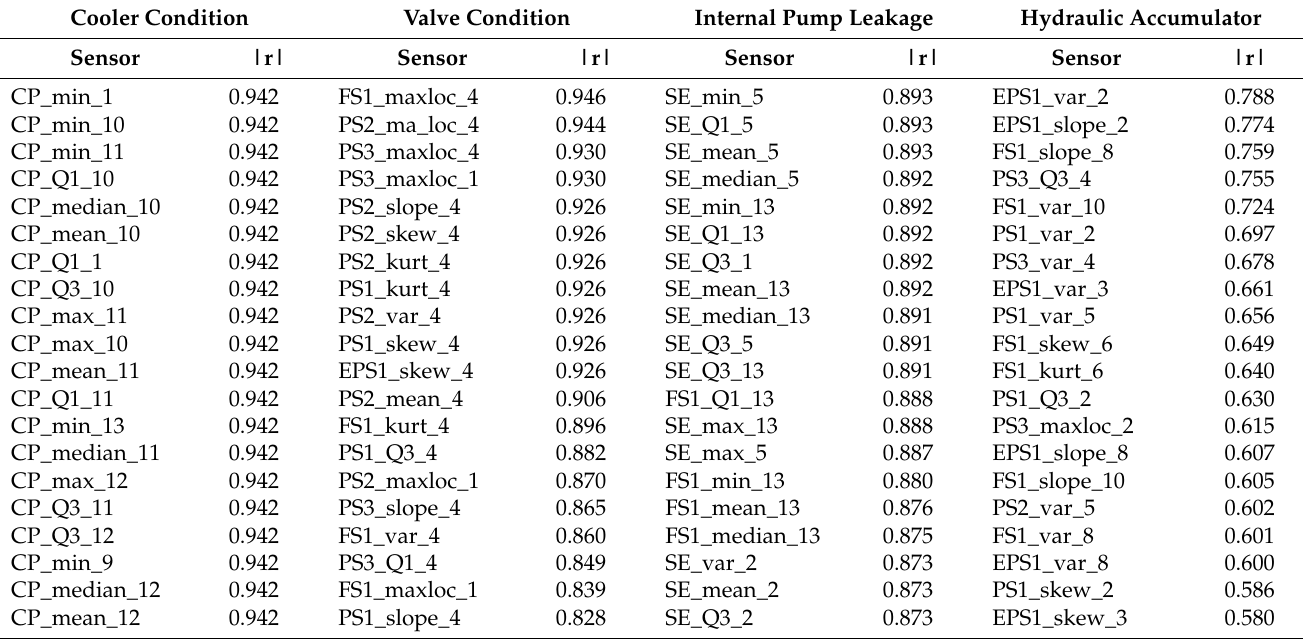
Table 3. Feature selection through Spearman’s rank correlation